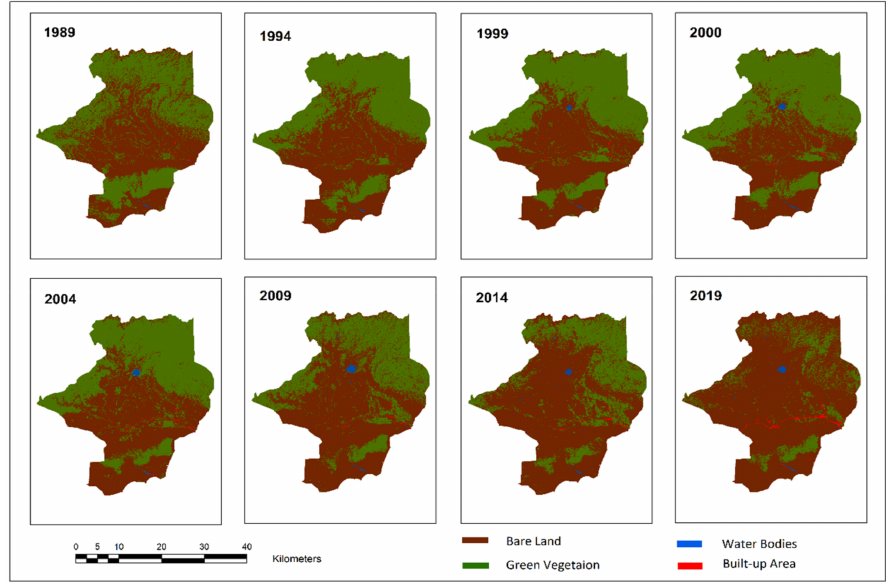
Figure 4. Land-cover classes for 1989, 1994, 1999, 2000, 2004, 2009, 2014, and 2019. The areas categorized as Water Bodies and Built-up Area cover less than 1% of the project area in total, however these classes have increased 4 to 5 times over the thirty years of the observed